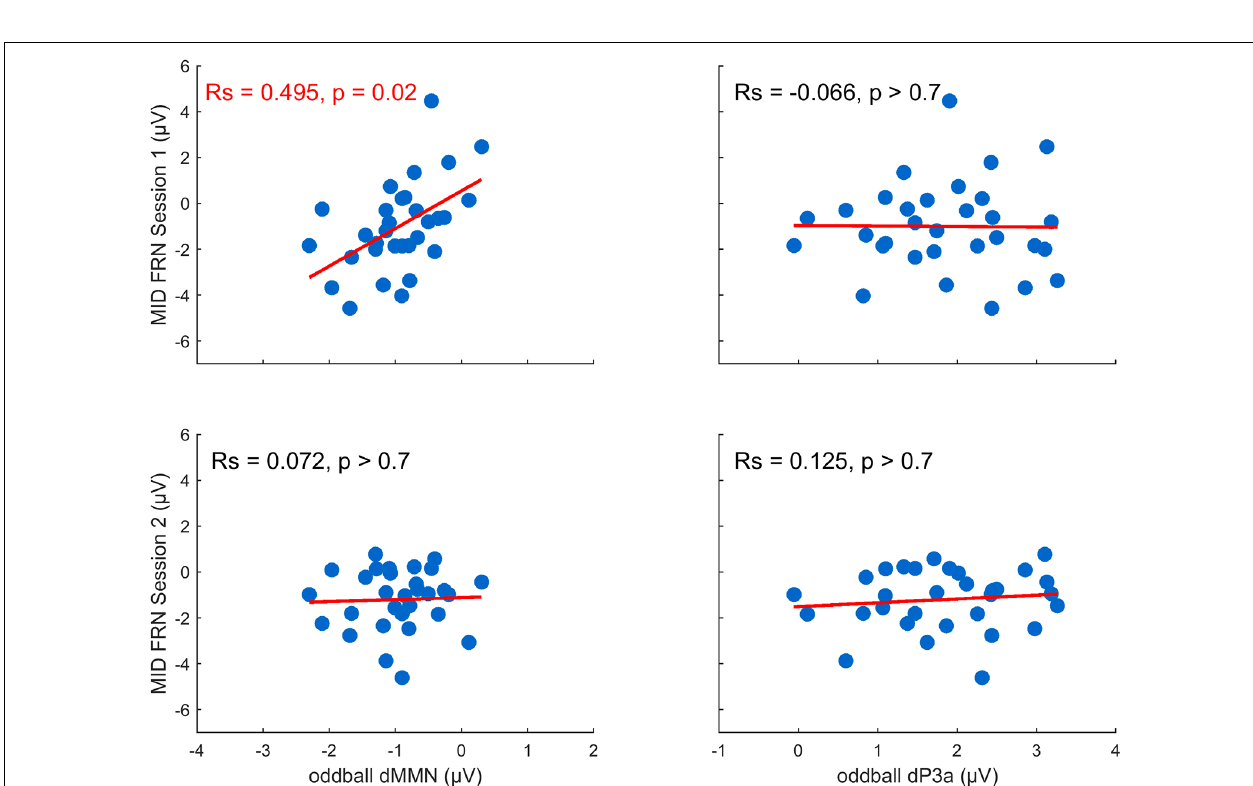
FIGURE 4 | Training-related changes in the MMN and P3a amplitude as a function of the feedback-related negativity (FRN) recorded in the first and the second MID task sessions (the p -values were